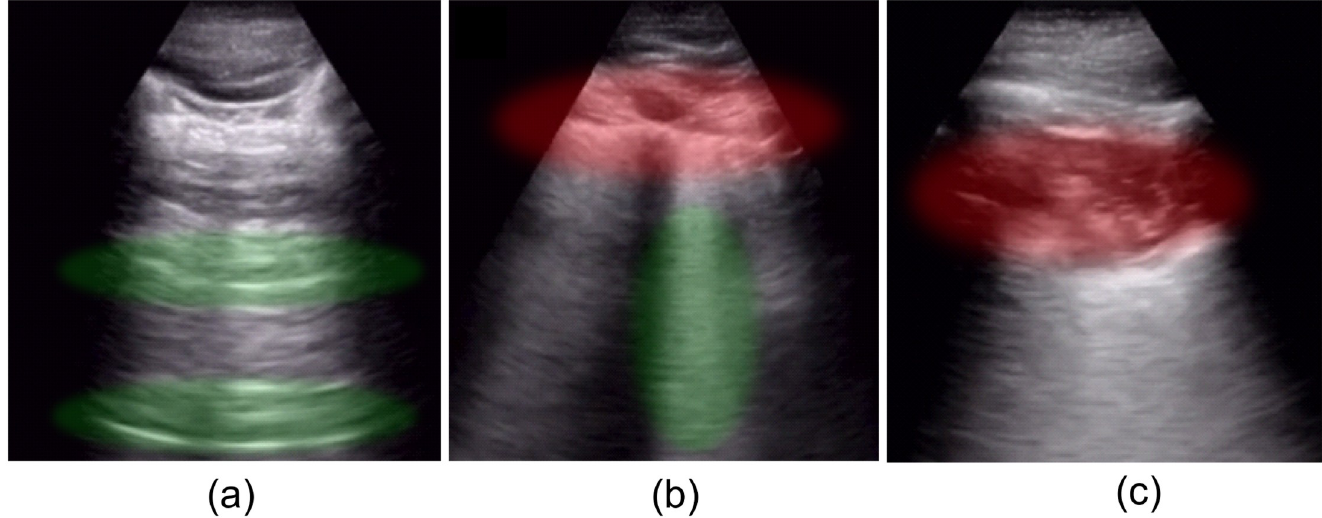
Fig 1. Artifacts. (a) normal lung with a regular pleural line, A-lines (green), and lung sliding; (b) infected lung with pleural line broken (red) and fused B-lines (green), (c) subpleural consolidation. Images were taken from the POCUS database [46].